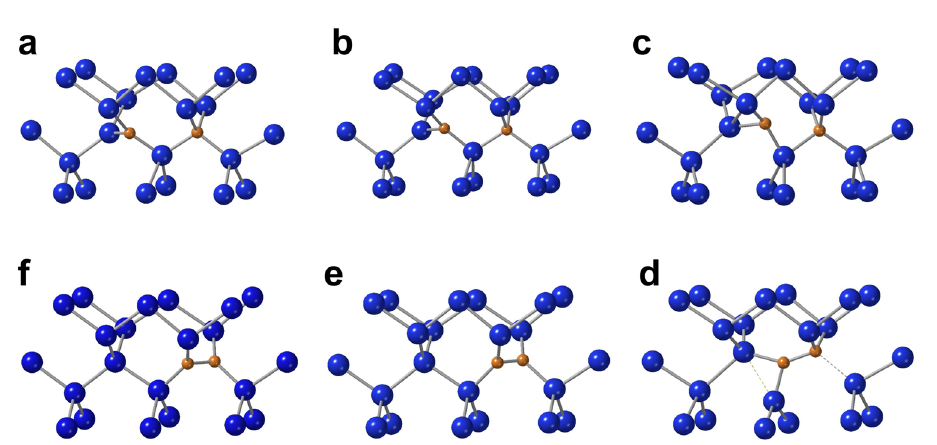
Fig. 3 | Path for the formation of the C - con fi guration upon the encounter of a diffusing (C – Si) Si split interstitial and a C Si substitutional. a – f The calculated con fi gurations along the reaction coordinate. Dashed lines indicate bonds in the breaking/forming, and are just guides to the eye.